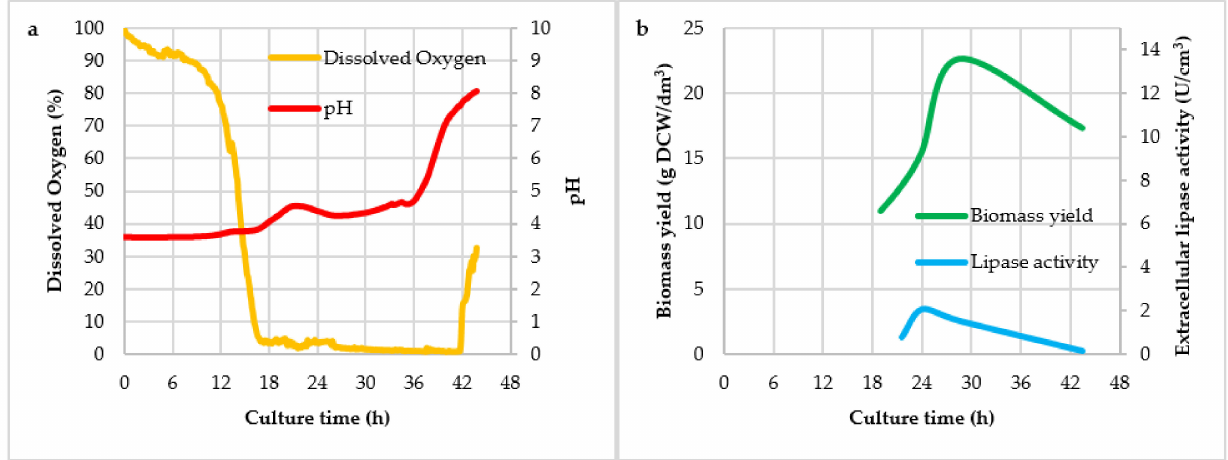
Figure 2. Kinetics of dissolved oxygen and pH ( a ) and biomass yield and extracellular lipase activity ( b ) of the yeast strain Y. lipolytica KKP 379 in the culture with an agitation speed of 400 rpm and air flow of 1 dm 3 /(dm 3 × min).